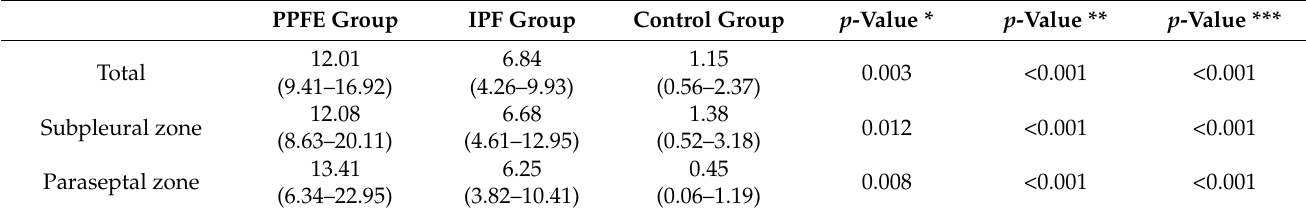
Table 2. Percentage of alveolar epithelial denudation in each group.